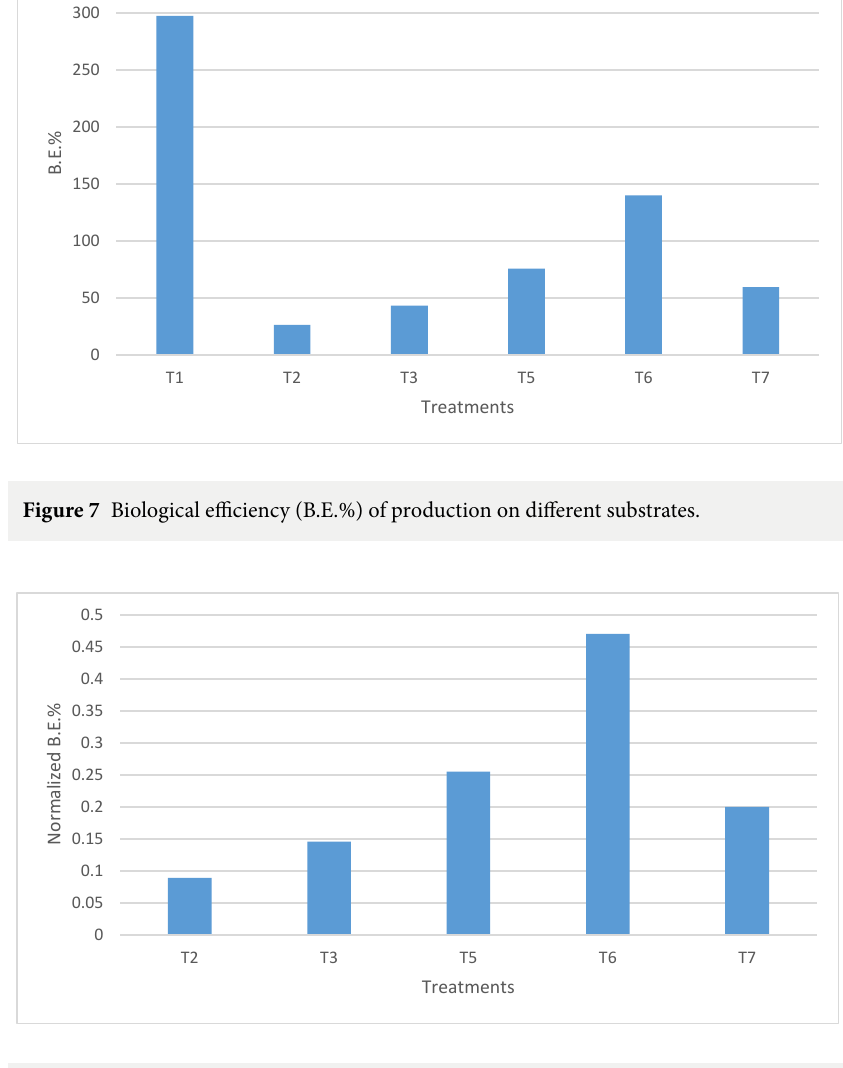
Figure 8 Normalized biological